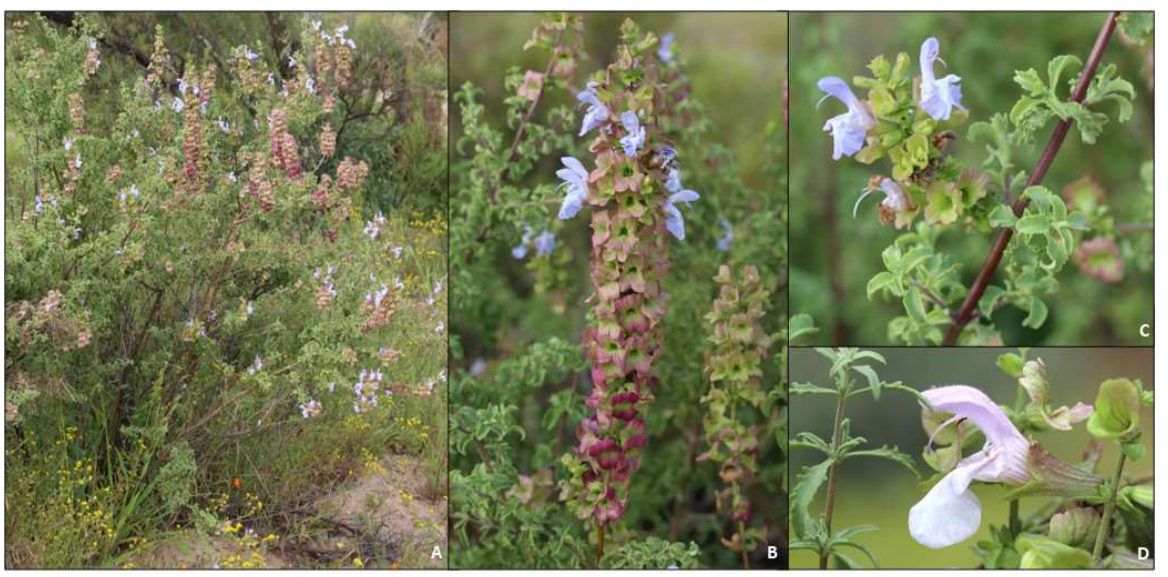
Figure 3. Morphology and diagnostic characters of Salvia dentata . ( A ) habit (near Garies); ( B ) inflo- rescence (near Garies); ( C ) leaves and flowers (Nieuwoudtville; note dentate leaf margins); ( D ) leaves and flower (near Middelpos; note dentate leaves and glandular calyx). All photographs taken by B.-E. Van Wyk.